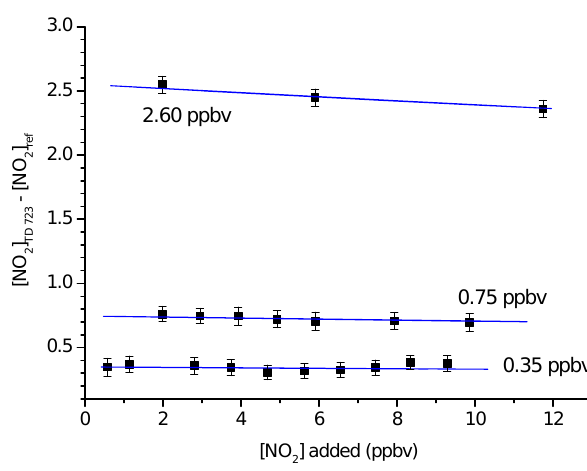
Figure 11. Measurements of the difference signal (TD cavity sam- pling from the 723K inlet – NO 2 reference cavity) when adding different amounts of NO 2 to 2-propyl nitrate samples (0.35, 0.75 or 2.6ppbv). The error bars represent standard deviation and were derived by propagating errors in the NO 2 signals in the TD and ref- erence cavities. The blue lines show the model predictions of the effect of adding NO 2 to the 723K inlet as described in the text.